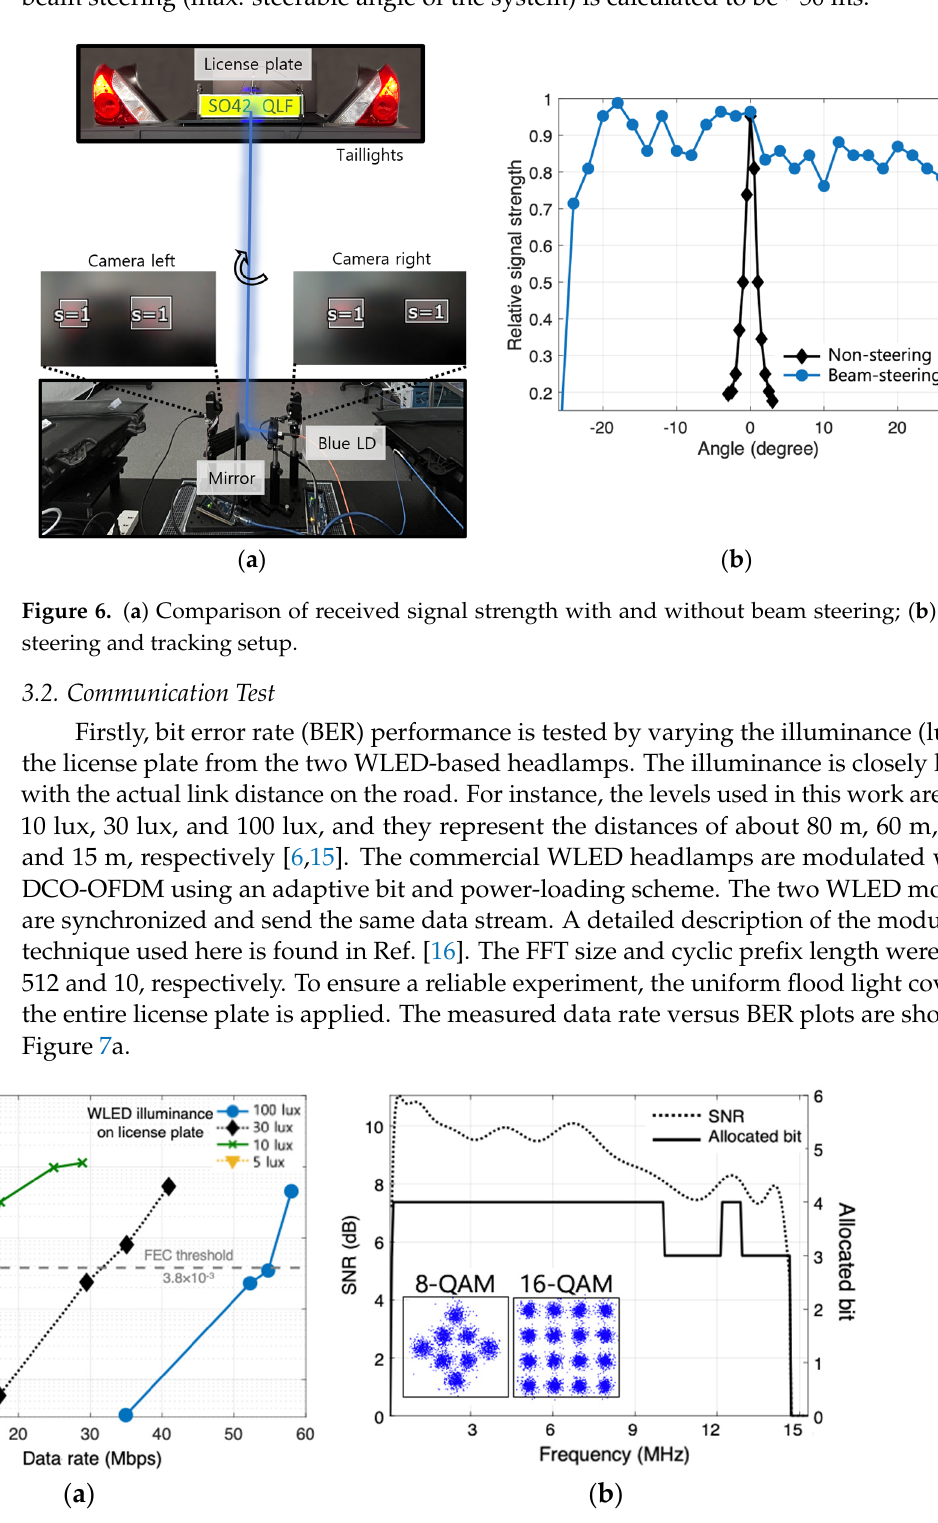
Figure 7. ( a ) BER performance according to different lux levels of LED headlamp; and ( b ) constella- tions, measured SNR and allocated bits with adaptive bit and power loading.